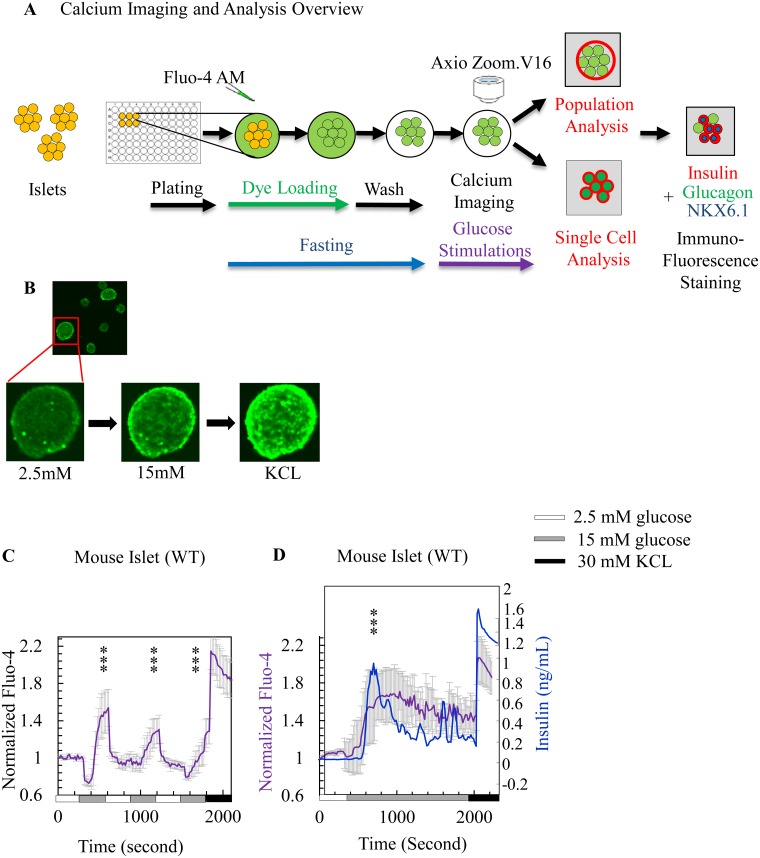
A rise in intracellular calcium corresponds to insulin secretion.(A) Overview of calcium imaging method for islets: intact islets were plated on a 96 well plate. Islets were stained with the Fluo-4 AM and then washed in fasting solution. Calcium influx of the population of cells in the islet or single cells was imaged following the addition of glucose. Same islets were imaged again after fixation and immunofluorescence staining with INS, GCG, and NKX6.1. (B) Representative images of WT mouse islets after stimulating with 2.5 and 15 mM glucose followed by 30 mM KCl. (C) Average normalized population measurements with standard deviation of dynamic Fluo-4 fluorescence intensity for WT mouse islets shown in Fig 1B (7 islets) with corresponding S1 Movie. The calcium influx response for each mouse islet was normalized to the starting fluorescence intensity data point during the initial low glucose incubation. The normalized fluorescence intensities of 7 WT mouse islets were averaged and plotted on the y-axis with standard deviations. Islets were challenged sequentially with 2.5, 15, 2.5, 15, 2.5, and 15 mM glucose and 30 mM KCl. Fluorescence was measured at 126 time points throughout the series of glucose challenges, normalized to the starting fluorescence intensity, and averaged across all islets at each time point. The standard deviation at each time point ranged between ± 2 to 8 a.u.c (area under the curve). The x-axis represents time (in seconds). P-value was calculated from the difference between ave a.u.c. during low glucose and high glucose stimulations. Significance of calcium influx response was labeled * when the P-value was between 0.05 and 0.001 and ** when the P-value was below 0.001. (D) Average normalized population measurements with standard deviation of dynamic Fluo-4 fluorescence intensity of a total of eight WT mouse islets with corresponding S2 Movie. Population measurements of dynamic normalized Fluo-4 fluorescence intensity for mouse islets is shown in purple, and the ELISA measurements of secreted mouse insulin for the same batch of islets is shown in blue. Challenges were done with 5 minutes of 2.5 mM, 25 minutes of 15 mM, and 5 minutes of 30 mM KCl.